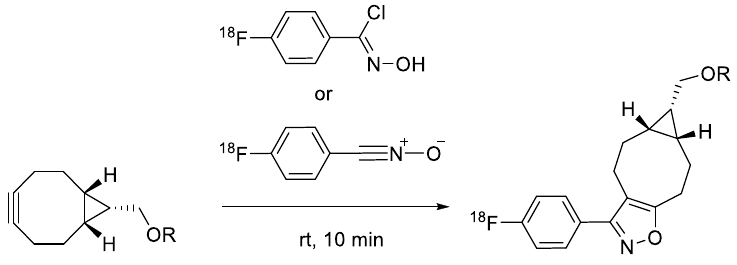
Figure 19. [3+2] cycloaddition reaction using 18 F-labeled nitriloxides or N -hydroxyimidoyl chloride. Molecules 2019 , 24 , x